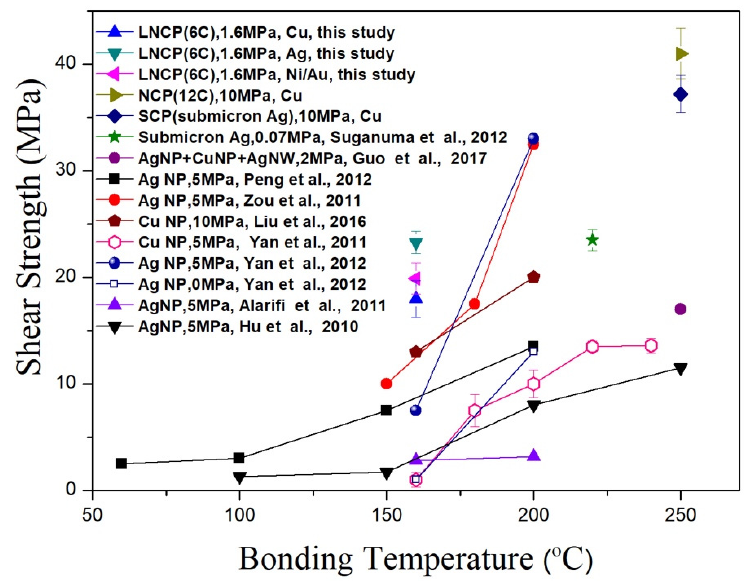
Figure 8. Comparison of strengths of joints bonded using NP pastes.